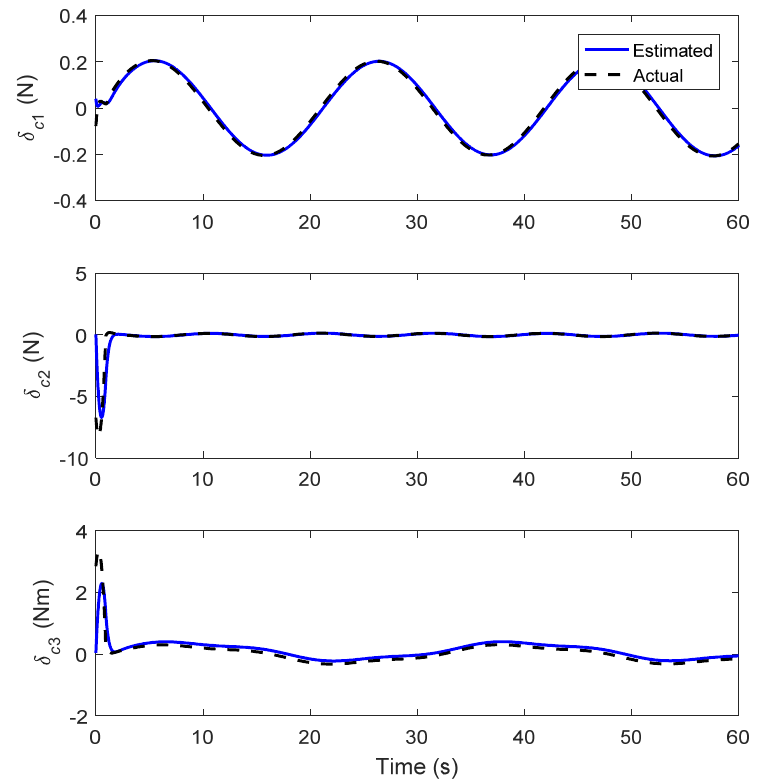
Figure 10. Matched lumped disturbance and estimation (Case 1).